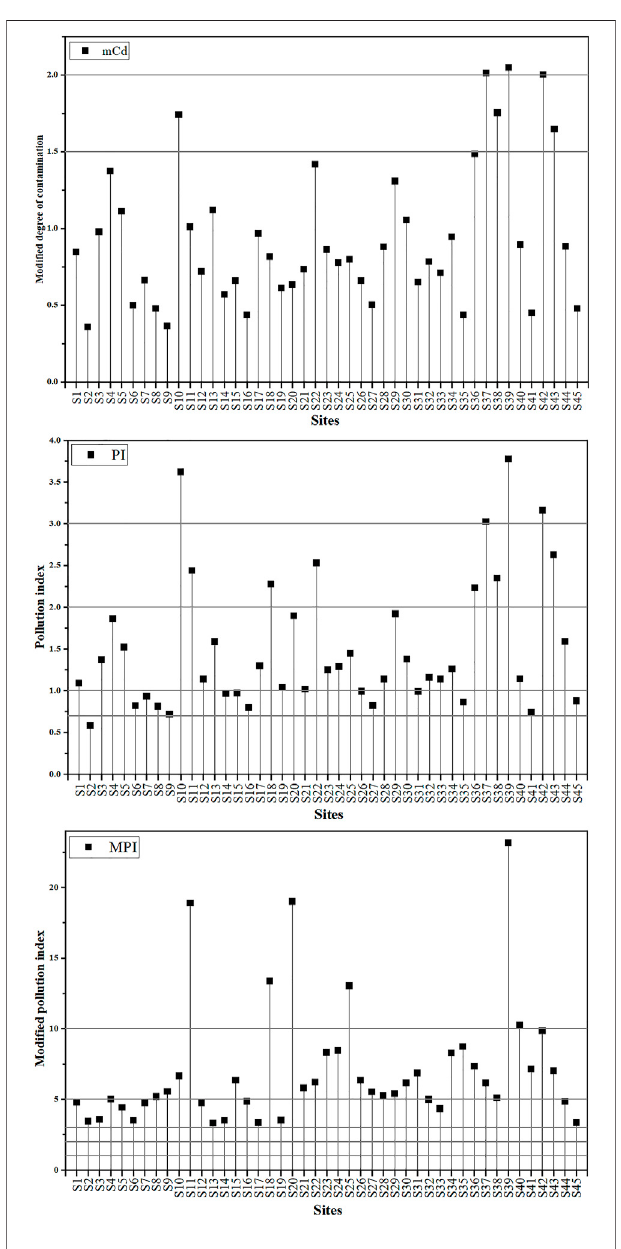
FIGURE 4 | Sediment quality assessment by multi-element indices (mCd: modi fi ed degree of contamination, PI: pollution index, and MPI: modi fi ed pollution